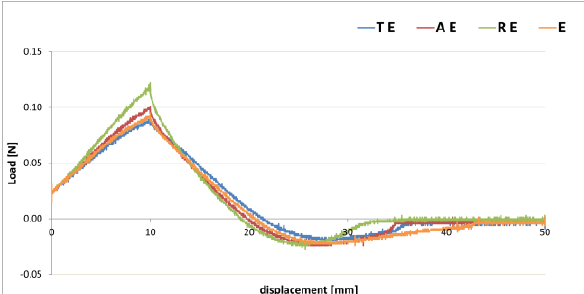
Figure 7. Texture curves obtained from an immersion/de-immersion test performed on the gel – creams E prepared with E at 0.7%, T E prepared with T at 0.2% w / w and E at 0.5% w / w , A E prepared with A at 0.2% w / w and E at 0.5% w / w , R E prepared with R at 0.2% w / w and E at 0.5% w / w . After adding the plant-based active PFP at 3% w / w to the gel – creams formulations, some structural modifications could be seen (Figure 8). The tan δ values of the formulation